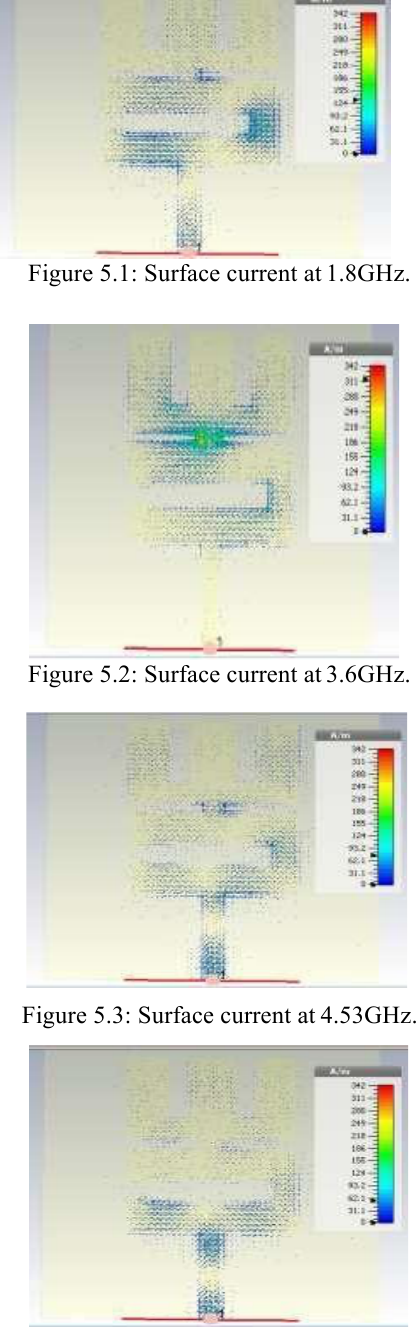
Figure 5.4: Surface current at